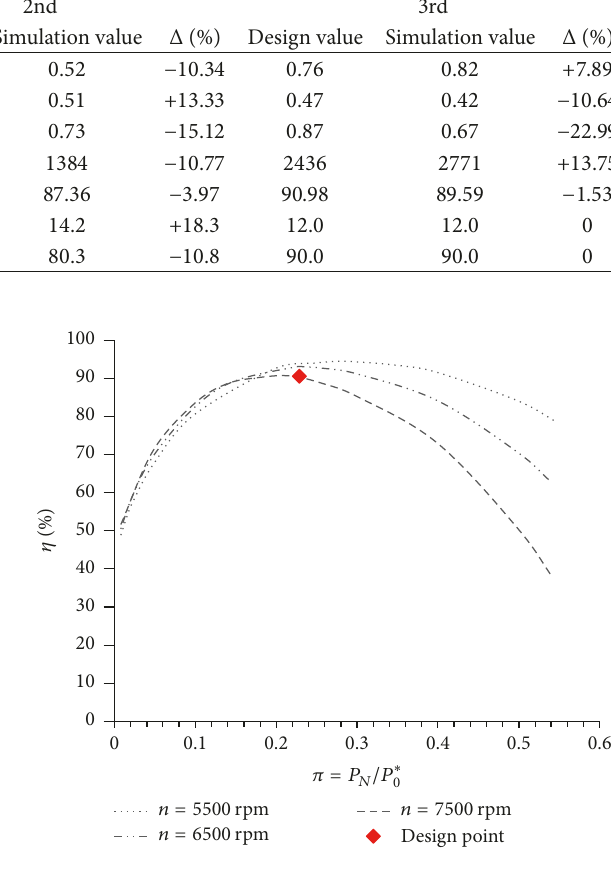
Figure 15: The variation of efficiency with pressure ratio at different speeds.